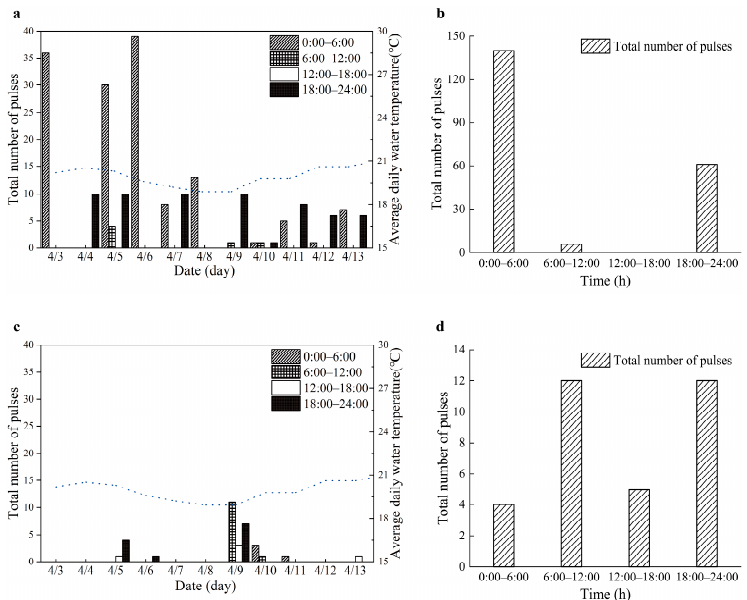
Figure 5. Temporal variation in different calling signals of Chinese bahaba: ( a ) Occurrence of single drum in four time periods from 3 to 13 April 2022, and ( b ) total number of pulses in four time periods during acoustic monitoring. ( c ) Occurrence of fast drum trains in four time periods from 3 to 13 April 2022, and ( d ) total number of pulses in four time periods during acoustic monitoring.